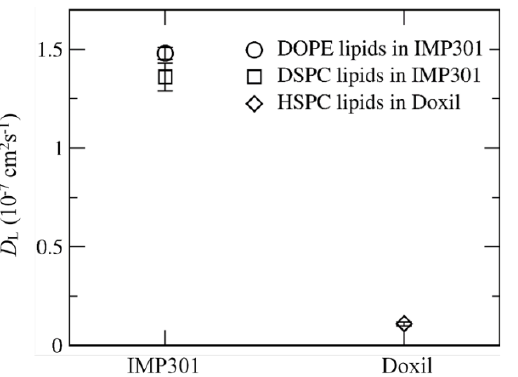
Figure 7. Mass density profiles for the phosphate group of lipids and the hydroxyl group of choles- terol for IMP301 and DOXIL.